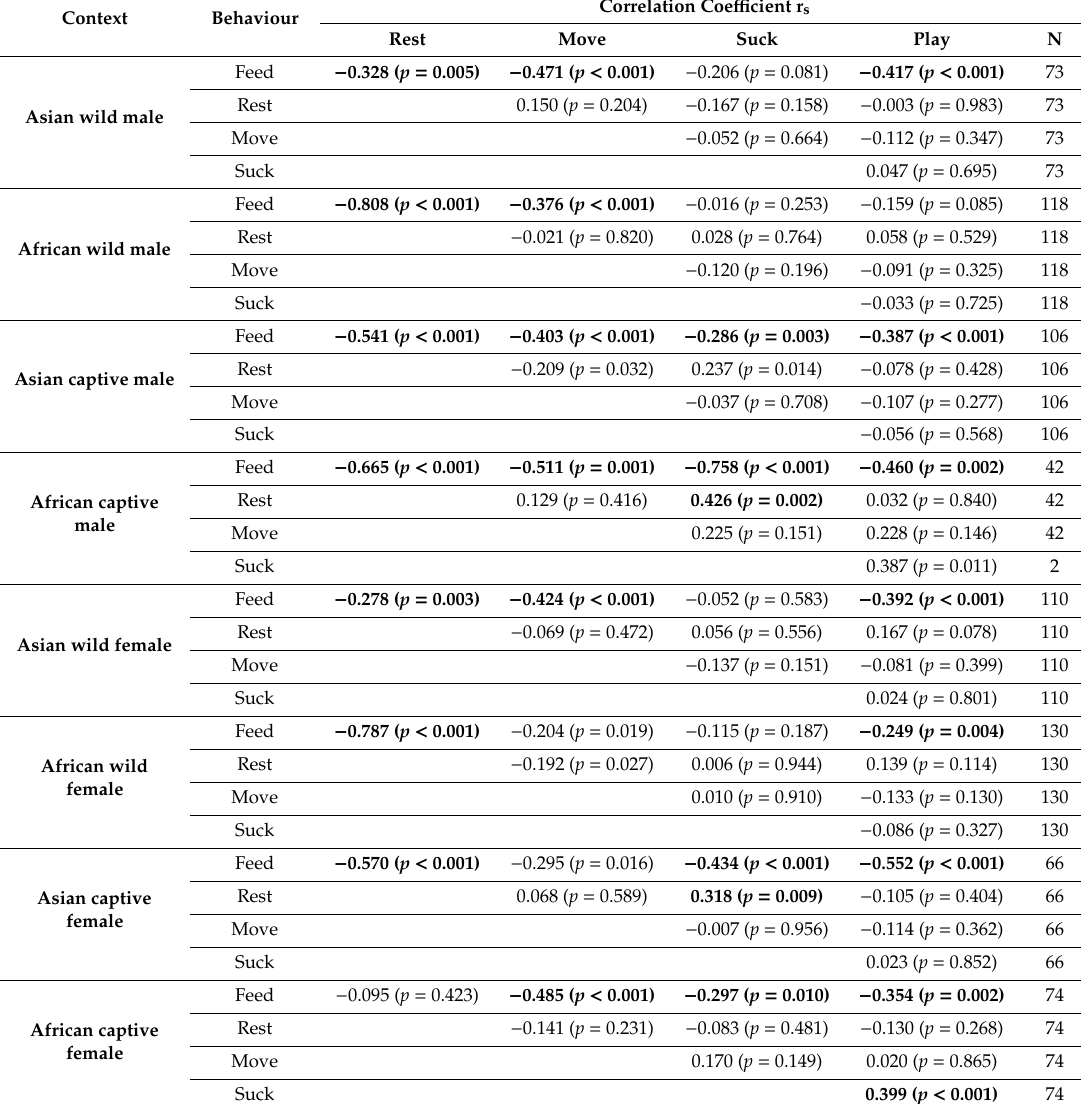
Table 6. Spearman correlations ( r s ) between major activities and total play across age categories of calves, separated by context and sex. Only correlations with probability greater than 0.005 are highlighted due to repeated tests between the four